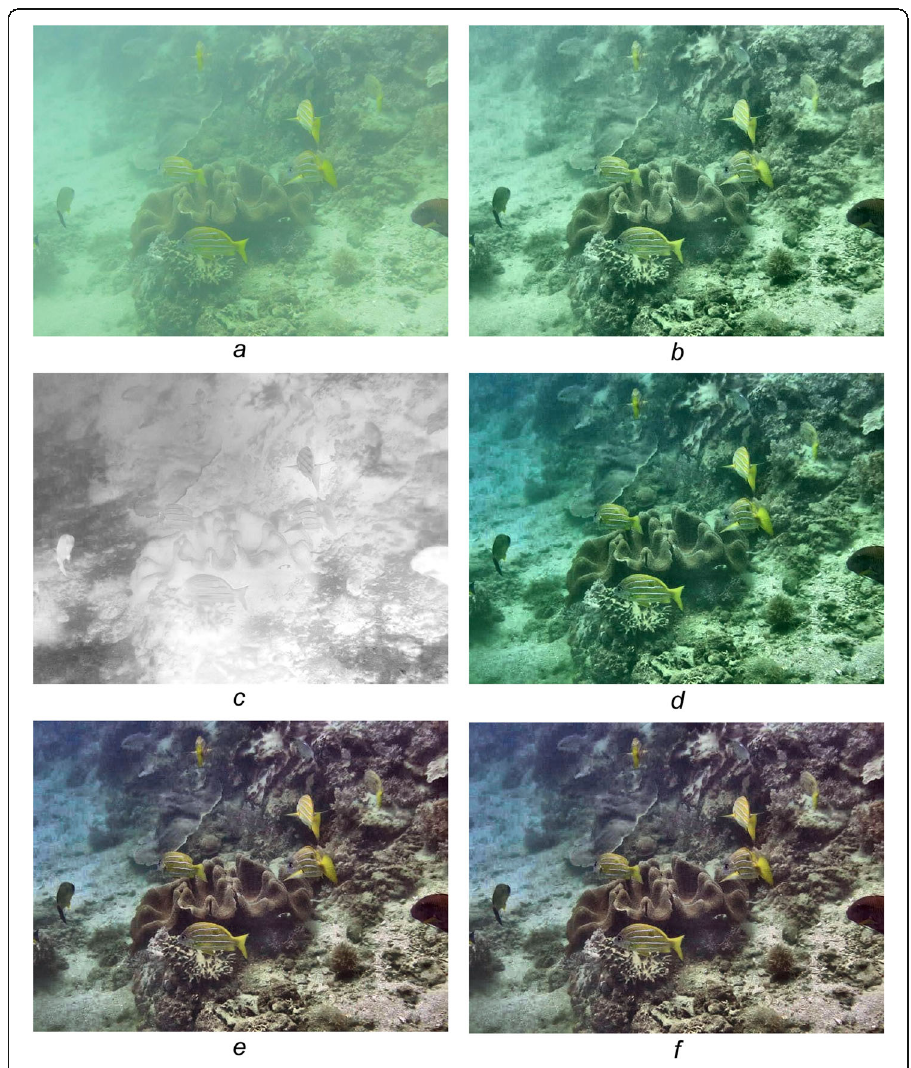
Fig. 1 Illustration of intermediate outputs. a Input image. b Local contrast-enhanced image. c Delicate transmission map. d Haze-removed image. e Color-corrected image. f Global contrast-enhanced